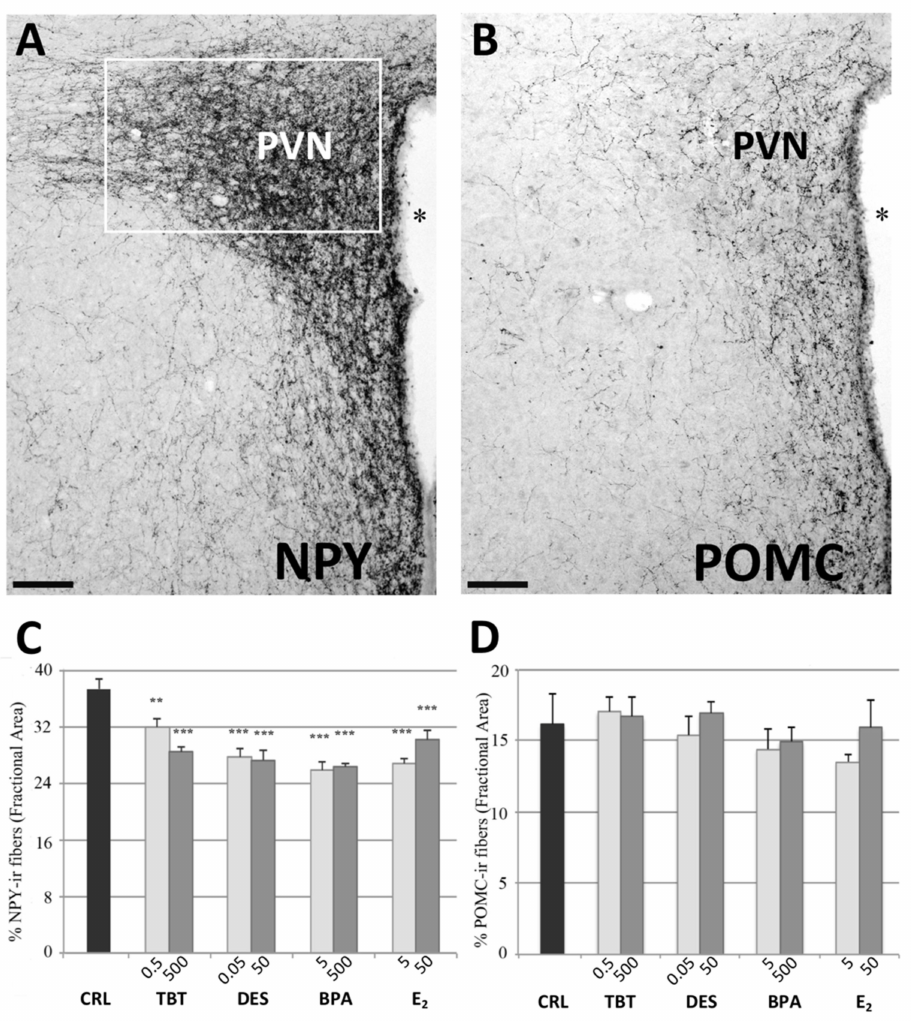
Figure 1. NPY and POMC immunohistochemistry in the PVN. Microphotographs and histograms illustrating the immunohistochemical immunoreactivity for NPY and POMC in the paraventricular nucleus (PVN). ( A ) Low magnification of a control mouse (CRL) illustrating the NPY immunoreactiv- ity in PVN. The white box represent the ROI selected for the quantitative analysis. ( B ) Low magnifica- tion of a control mouse (CRL) illustrating the POMC immunoreactivity in PVN. Scale bar = 100 µ m. * = Third ventricle. ( C , D ) Histograms illustrating the quantitative analysis of the fractional area covered by NPY (C) and POMC (D) immunoreactivity in the PVN. Bars represent the mean and the standard error of the mean (SEM). Asterisks indicate significant differences (Fisher’s test) of the experimental groups in comparison to controls (CRL): ** p < 0.01, *** p <